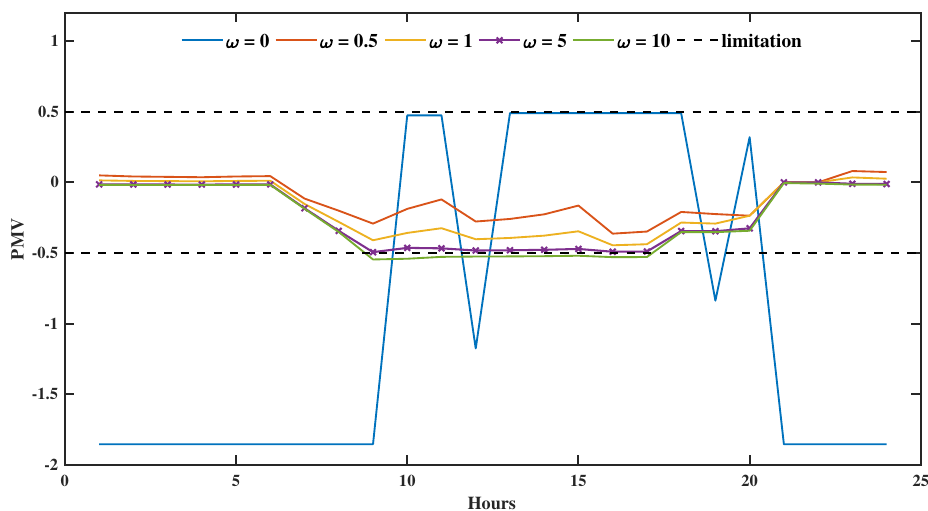
Figure 12. The value of PMV for different weighting factors in case